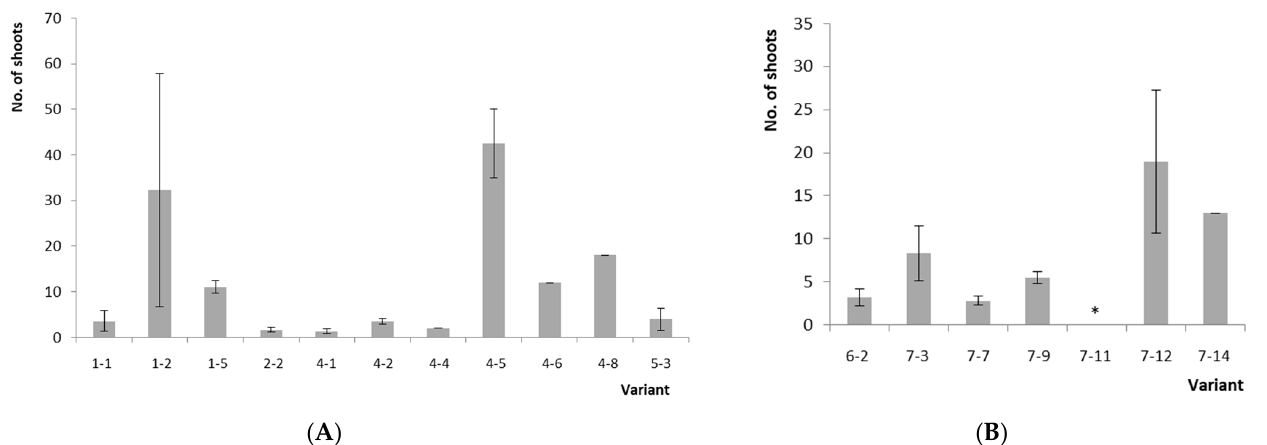
Figure 3. The multiplication rate of variants V.ul. 8 × ‘NC’ ( A ) and V.ul. 8 × ‘SC 5-8’ ( B ) on Anderson medium, supplemented 5 μМ 2iP at the 2nd passage. Data are presented as mean values with confidence intervals ( p ≤ 0.05). N = 1–6. Note: *—callusogenesis of variant No. 7-11.